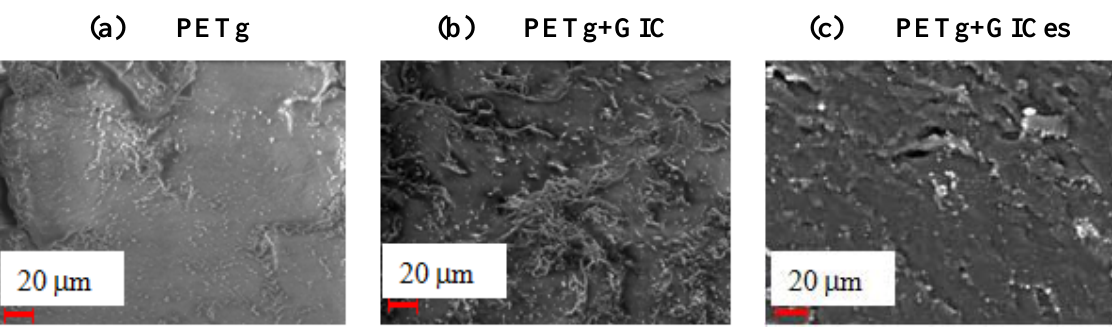
Figure 7. SEM micrographs of fractured surfaces.